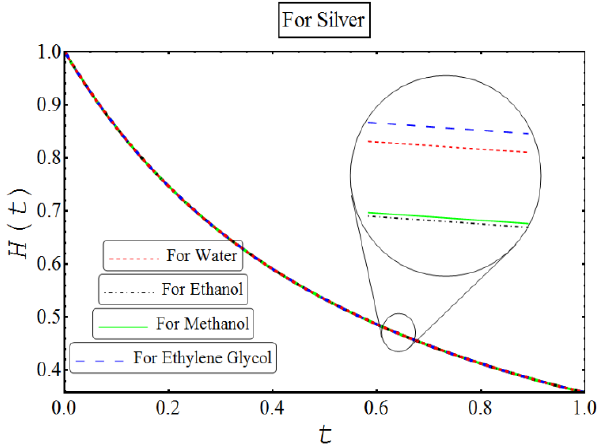
Figure 3. Behaviour of film thickness for different base fluids containing silver particles